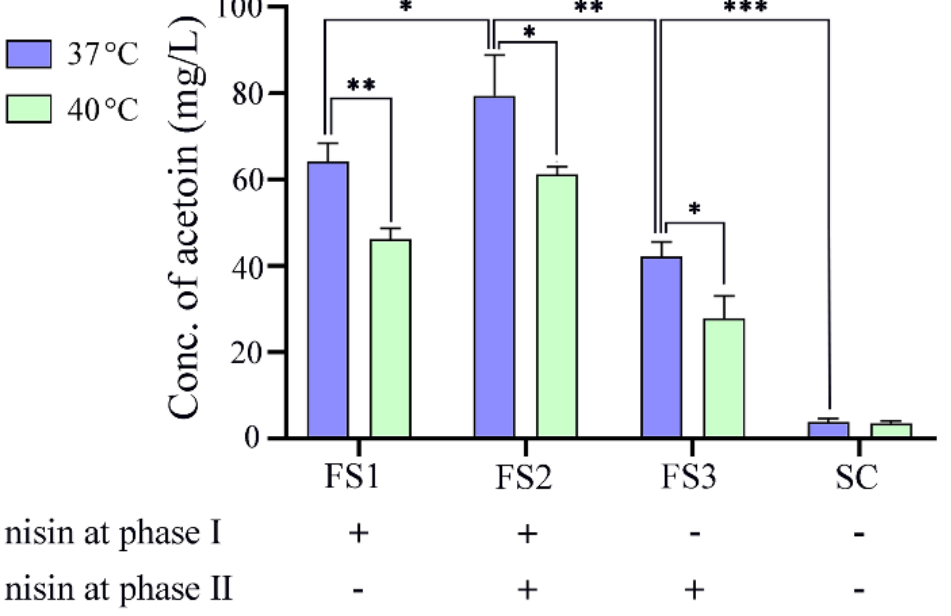
Figure 6. Acetoin production in NZ9000/pNZ8048- aldC fermented soybeans. + and − indicate with or without nisin induction at phase I and II. SC is short for soybean control. The error bars show standard deviations from three repeated experiments, and significant differences are presented as * ( p < 0.05), ** ( p < 0.01) and *** ( p < 0.001).